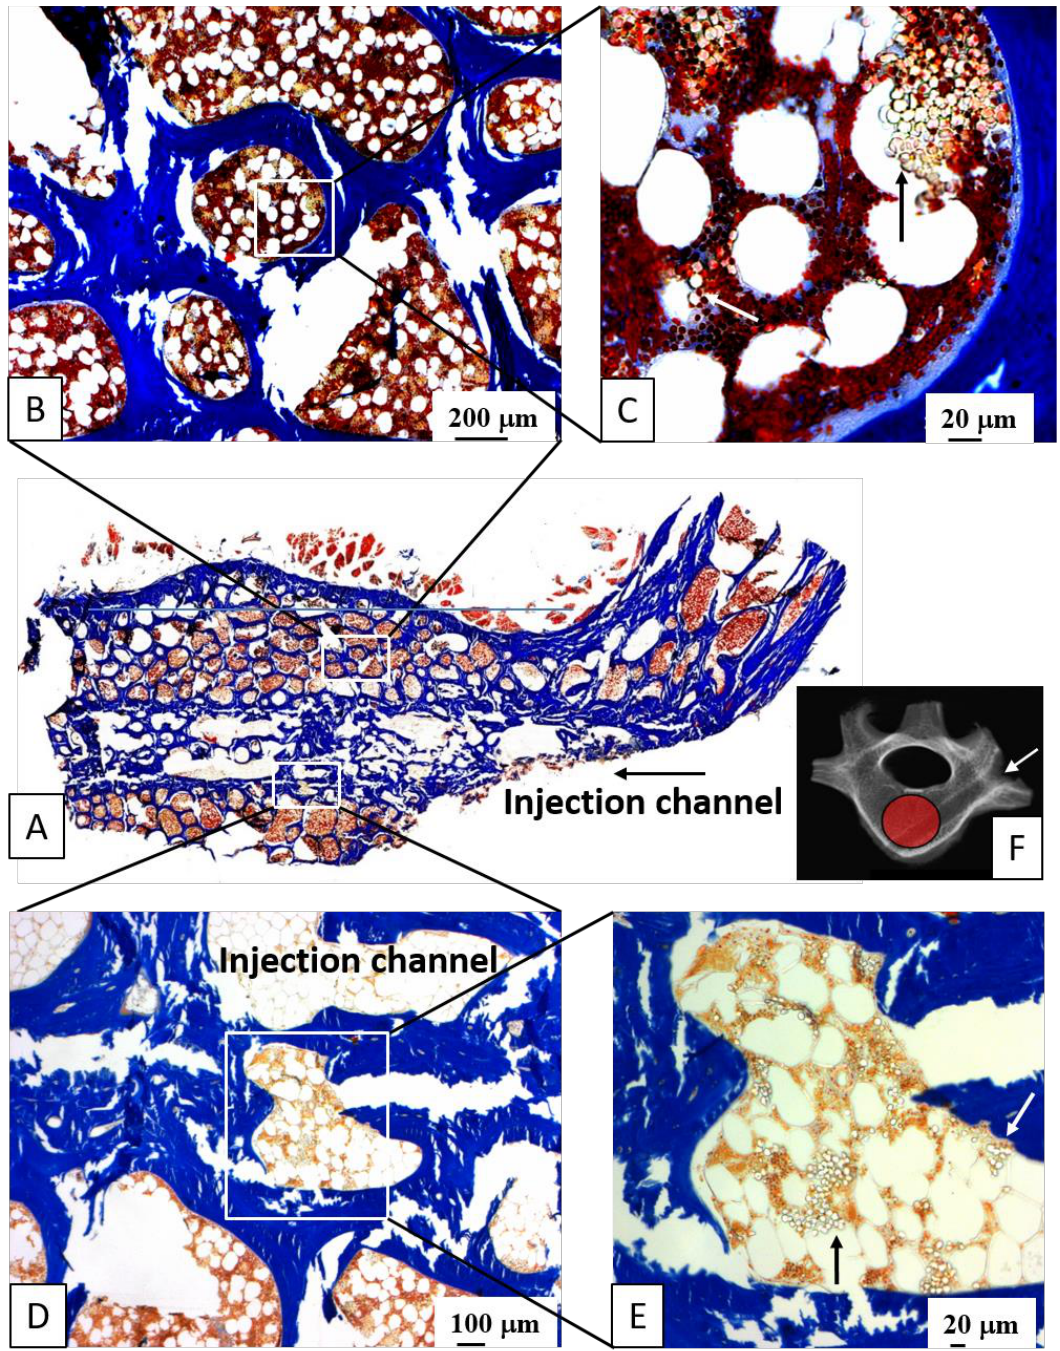
Figure 4. Light field ( A , B , D ) and phase contrast histology images ( C , E ) of therapeutically injected hydroxyapatite (HA) particles (see arrows in ( C , E )) in plastic-embedded sections of lumbar vertebral bodies (L4 = HA/BMP-2; 10 µ g; 3 months); trichrome stain according to Masson-Goldner, staining bone trabeculae including newly formed bone, as well as corticalis in blue, bone marrow including hematopoietic cells and fat marrow in brown/white, and HA particles in contrasted white (see arrows); ( F ) macro X-ray of the injected vertebral body demonstrating the placement of the injection channel (white arrow) and the spongiosa cylinder harvested for biomechanical analysis (red circle).